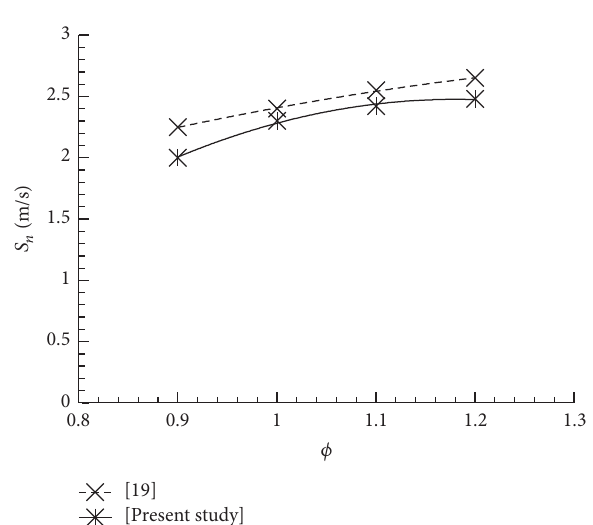
Figure 7: Comparison of the value of 𝑆 𝑠 for anhydrous ethanol between [19] and present study.